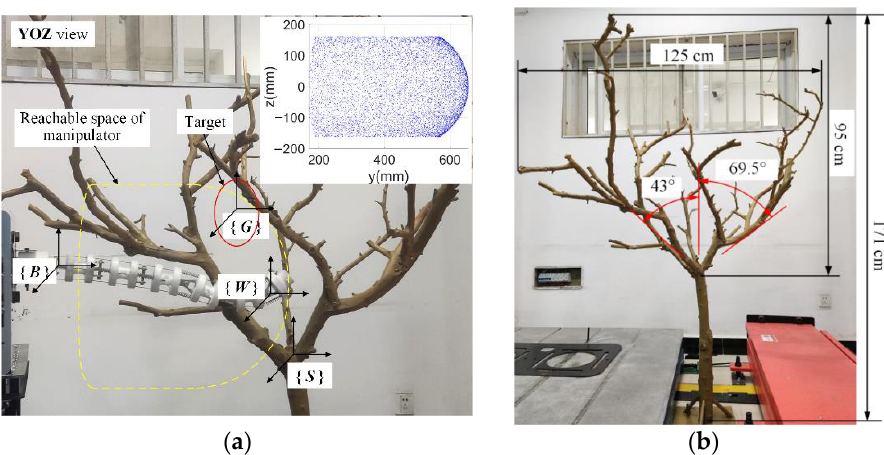
Figure 11. ( a ) The reachable space and position of the CDFM; ( b ) dimensions of the model tree.